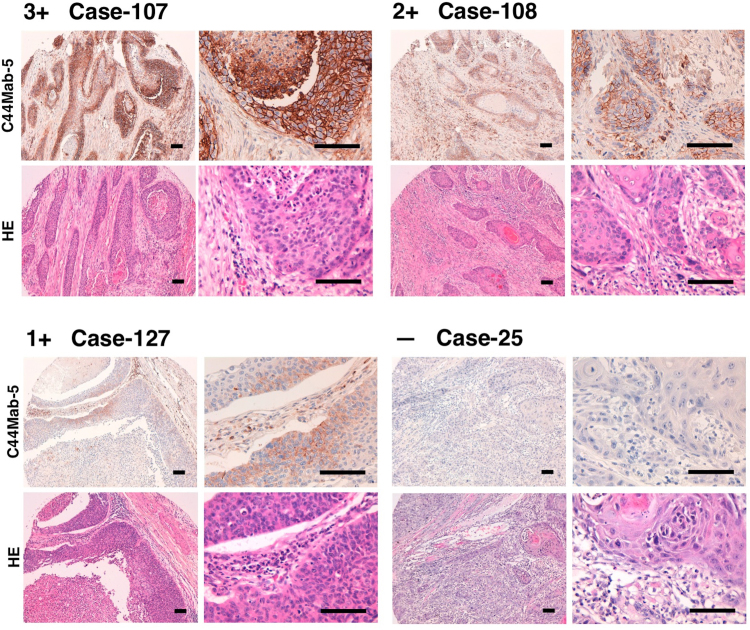
Immunohistochemical analysis of C44Mab-5 against oral SCCs. After antigen retrieval, sections were incubated with 1 μg/mL of C44Mab-5 followed by treatment with the Envision+ kit. The color was developed using 3,3-diaminobenzidine tetrahydrochloride (DAB), and sections were counterstained with hematoxylin. Hematoxylin & eosin staining (HE) was also performed. Scale bar = 100 µm.